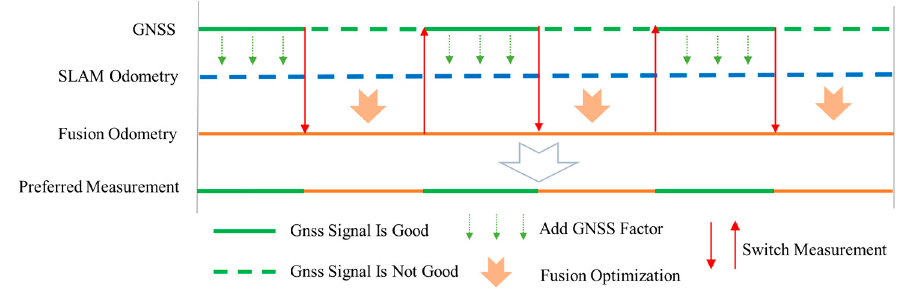
Figure 5. Update amount supply system. SO switch measurement between GNSS and fusion odometry is used to obtain the preferred measurement. The high-quality area of the GNSS signal is distributed in segments due to environmental impact. When the signal is good, it is directly selected as the update amount, and the GNSS factor is added to the SLAM system to form a fusion odometer. When the signal is poor, the fusion odometer is selected as the update amount. The fusion optimization is implemented based on the factor graph fusion system in Figure 3.